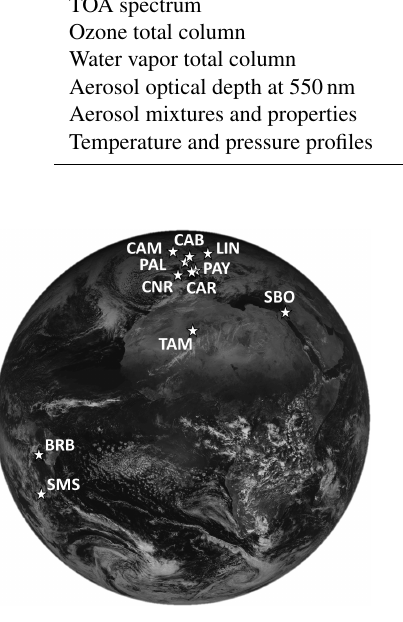
Figure 4. BSRN ground stations used for validation in this study, in the field of view of Meteosat Second Generation (0.6µm channel).